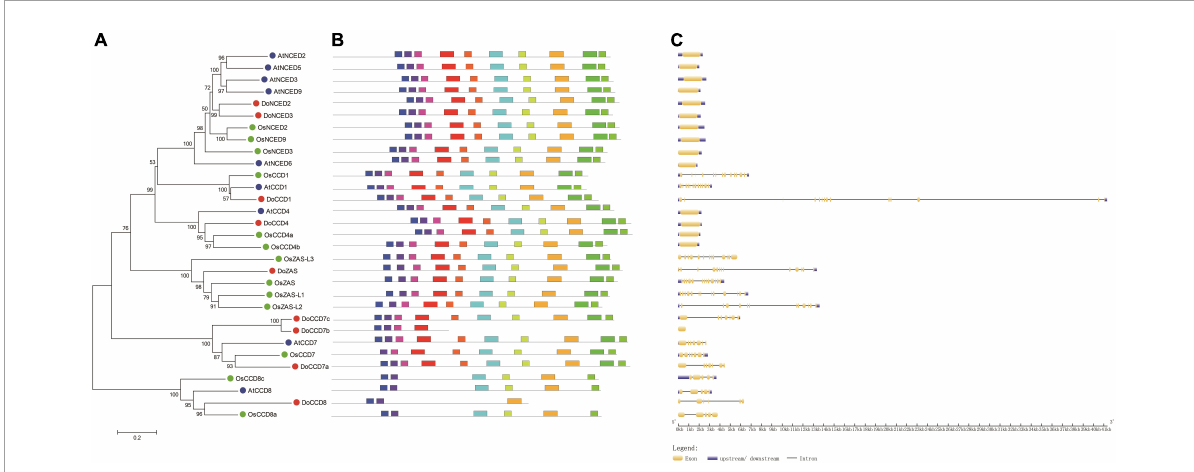
FIGURE3 Phylogenetic analysis and characterization of CCD genes from three species. (A) The phylogenetic tree of 31 CCD proteins. CCD proteins were aligned with ClustalW and an unrooted tree was constructed using MEGA 7.0 with the neighbor-joining method and bootstraps of 1,000 replicates. (B) Ten conserved motifs were analyzed in CCD proteins. (C) The exon-intron structures of CCD genes were analyzed. At , Do and Os stand for Arabidopsis thaliana , Oryza sativa and Dendrobium officinale ,